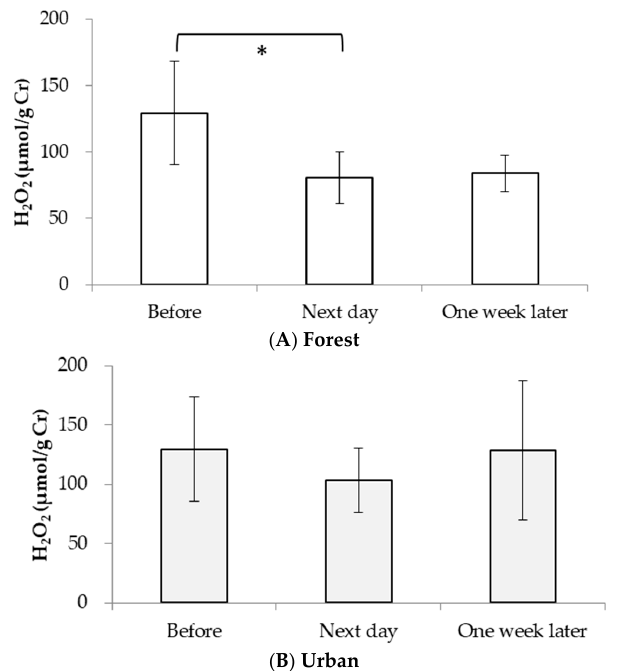
Figure 2. ( A ) Urinary H 2 O 2 levels before, the next day and one week after the forest or urban walk (* p < 0.1: pre ‐ forest walk vs. the day after the forest walk). ( B ) Urinary H 2 O 2 levels before, the next day and one week after the urban walk.